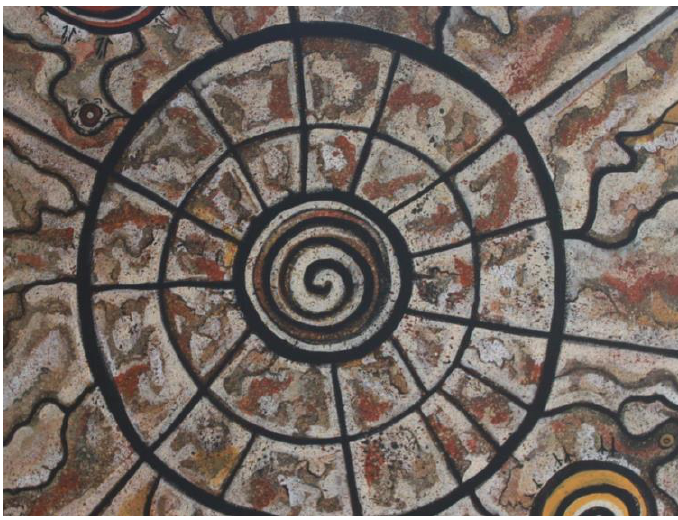
Figure 3. Visual knowledge of relationships to cultural place and spiritual space; Acrylic painting on canvas by Belanjee, illustrating concentric circles of cultural connections within place and radiating lines of the relationships within